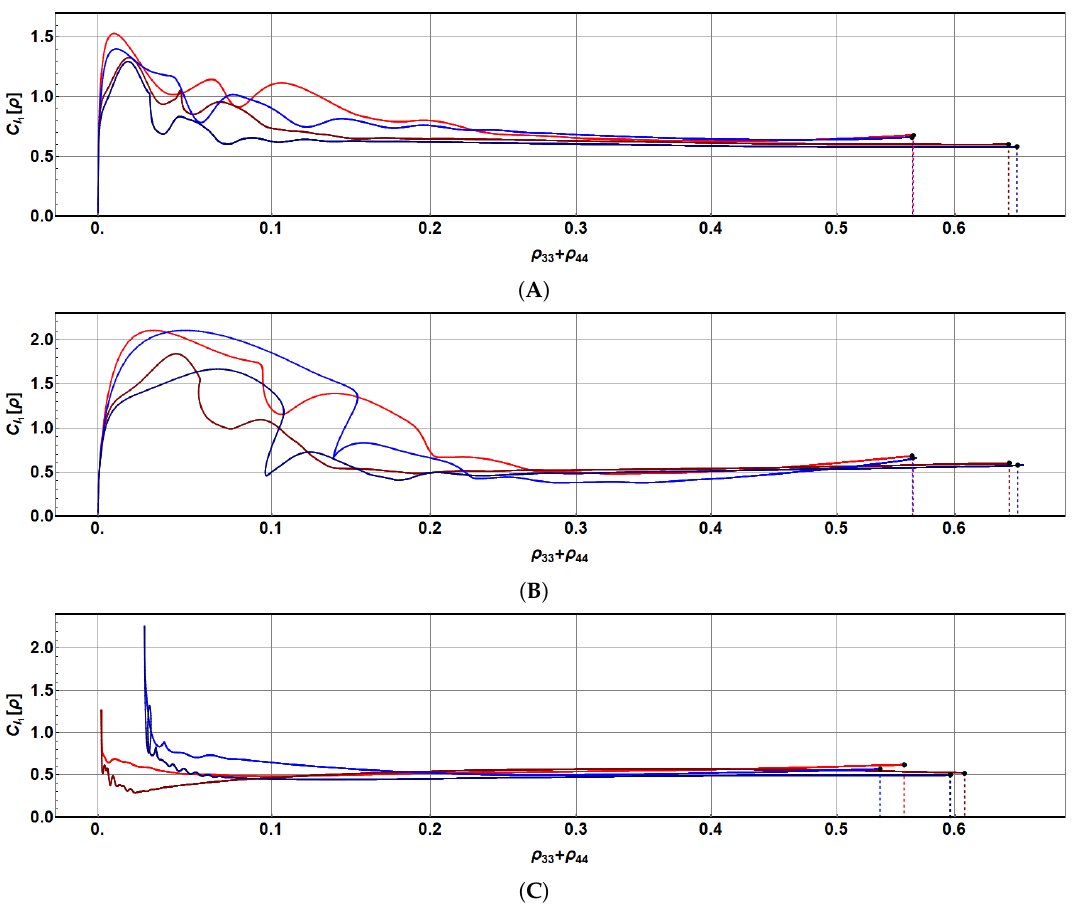
( ρ ) versus ρ + ρ 33 44 converging to η (in log-scale) for 1 FRET